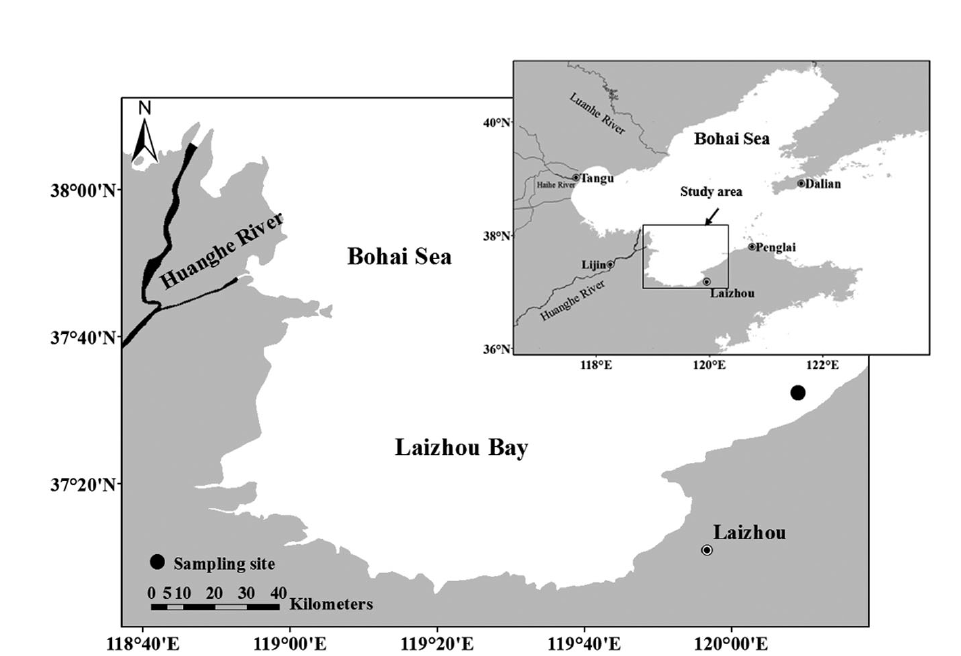
Fig. 1. Location of experimental site in Laizhou Bay ( d ), northern China